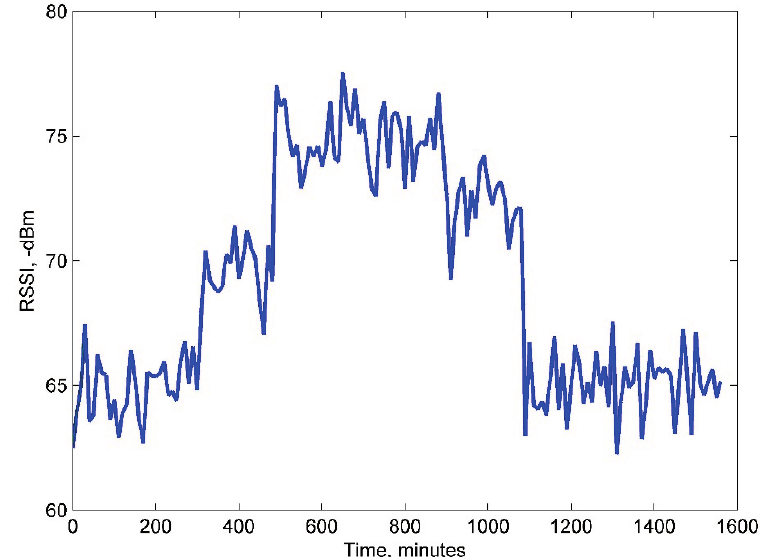
Figure 13. The RSSI evaluation during 1560 min (approximately 26